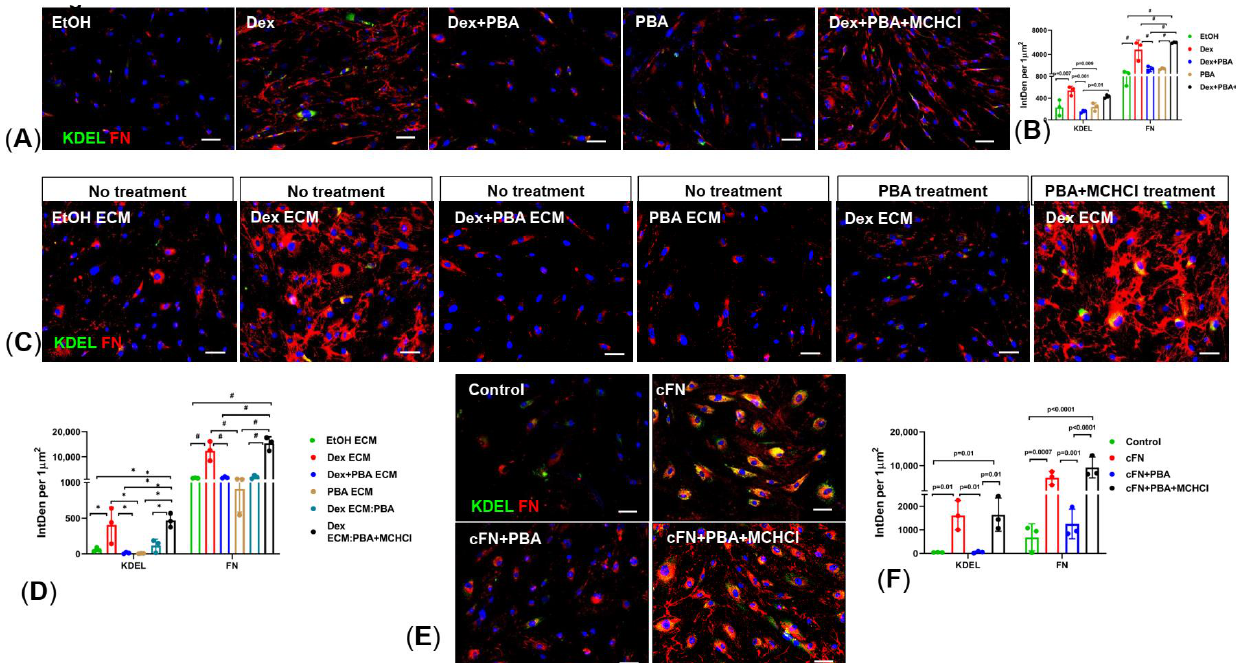
Figure 7. Inhibition of MMPs alleviates PBA’s effect on abnormal ECM degradation and its associated ER stress: ( A , B ) Primary human TM cells were treated with either ethanol, Dex (100 nM), Dex + PBA (5 mM), or PBA and Dex + PBA + MCHCl (200 µ M) for 7 d. PBA significantly reduced Dex-induced ECM deposition and its associated ER (Dex + PBA) in TM cells. However, in the presence of MMP inhibitor MCHCl, the effect of PBA was abrogated to reduce ECM deposition and ER stress in cells treated with Dex + PBA + MCHCl. ( C , D ) Primary human TM cells were re-grown on decellularized ECM derived from either ethanol or Dex (100 nM) or Dex + PBA (5 mM) or PBA. The regrown TM cells on Dex-derived ECM showed reduced ER stress (KDEL) and degradation of ECM (FN) upon PBA treatment (Dex ECM: PBA treatment) compared to untreated regrown TM cells on Dex-derived ECM (Dex ECM). However, the regrown TM cells on Dex-derived ECM showed prominent increase in ER stress and ECM, when the cells were co-treated with PBA and MCHCl (200 µ M) (Dex ECM: PBA + MCHCl treatment). ( E , F ) PBA reduced ER stress (KDEL) by degrading cFN in TM cells, treated with cFN (10 µ g/mL) + PBA (5 mM) compared to cFN alone treated cells. However, in the presence of MCHCl (200 µ M), PBA unable to degrade cFN and thus observed induction of ER stress in TM cells, treated with cFN + PBA + MCHCl. ( n = 3, ONE WAY ANOVA with multiple comparison, * indicates p < 0.05, # indicates p < 0.0001, scale bar 50 µ